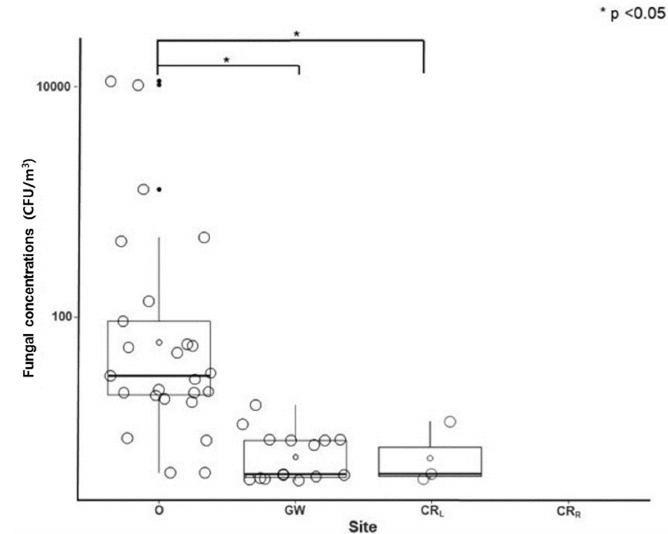
Figure 3. Comparison of fungal concentration by site. Abbreviations: CFU, colony-forming unit; CR L , lounge of the cleanroom; CR R , patients’ room in the cleanroom; GW, general wards; O, outside the hospital.